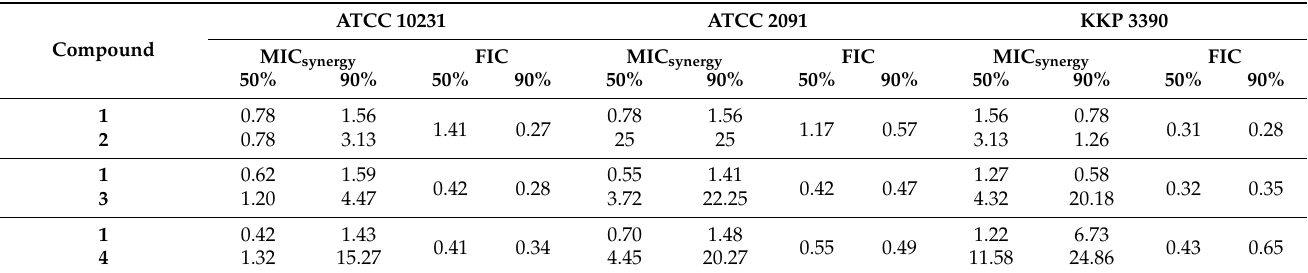
Table 1. Determination of the MIC in the combination and the FIC values* for the 2,3,4 phthalide lactones and fluconazole in Candida albicans ATCC 10231, C. albicans ATCC 2091, C. guilliermondii . ATCC